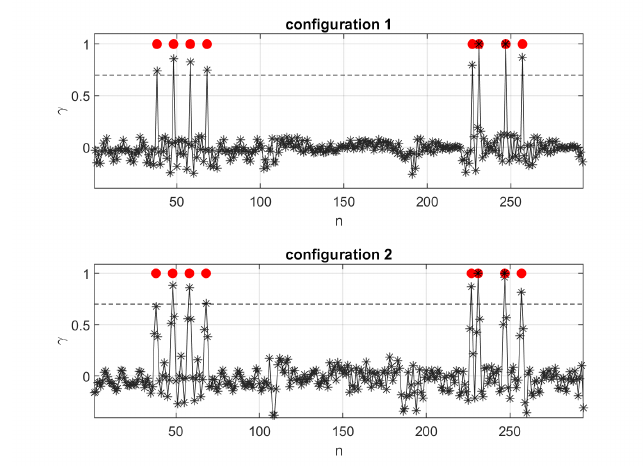
Figure 7. Bars’ detection ( top ) and reconstructed γ ( n ) ( bottom ). Red circles represent actual bars (one bar is displaced with respect to Figure 5). Black stars represent detected bars. A threshold of 0.7 has been applied.